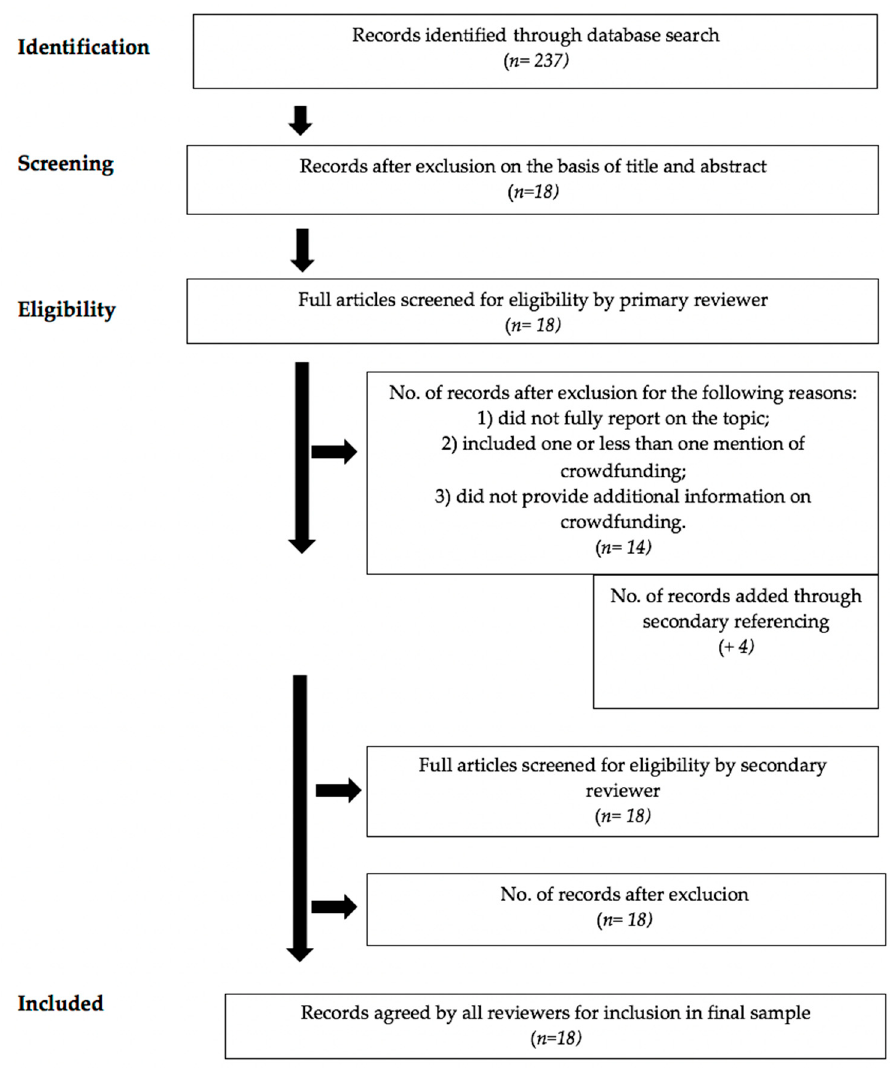
Figure 1. PRISMA flow diagram—schematic view of search strategy.